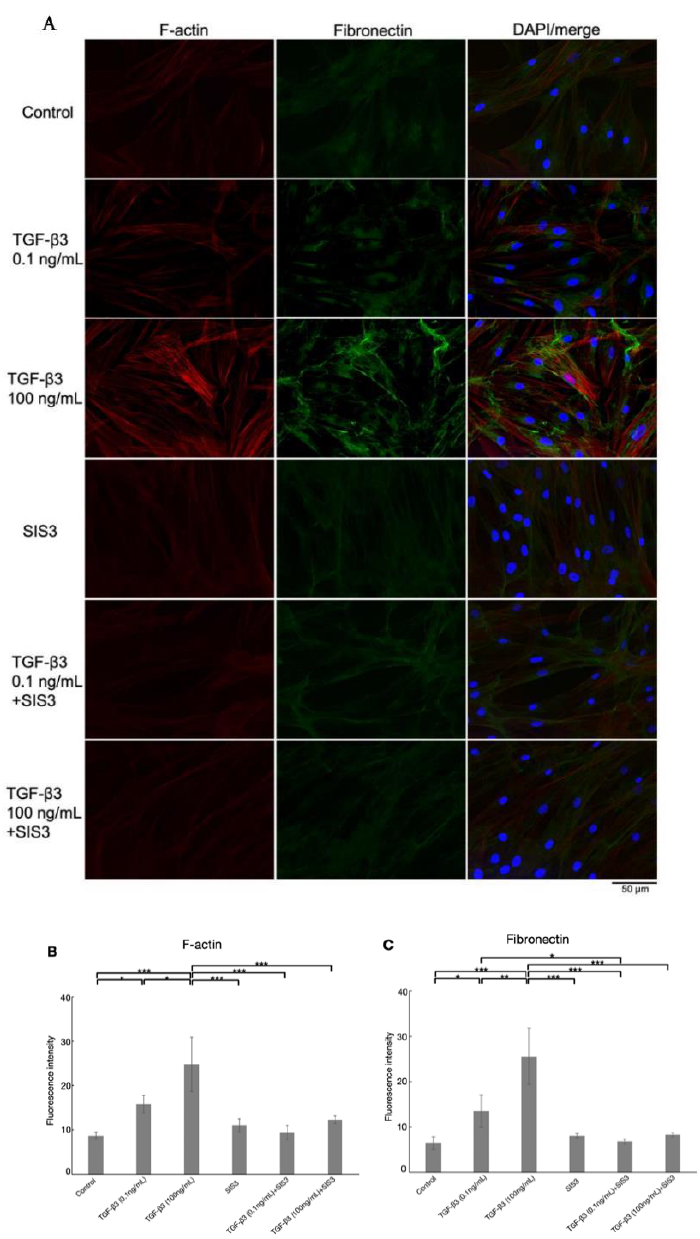
Figure 7. ( A ) Immunocytochemistry of F-actin and fibronectin in HTM cells after treatment with TGF- β3, with or without the Smad3 inhibitor, SIS3, and ( B , C ) the quantitative results based on immunocytochemistry. The left panels show cells stained for F-actin (red). The middle panels show cells stained for fibronectin (green). The right panels show merged images. The levels of F-actin were increased by 0.1 and 100 ng/mL TGF- β3 significantly, but the changes treated with 100 ng/mL TGF- β3 were suppressed by cotreatment with SIS3 significantly. The levels of fibronectin were significantly increased with 0.1 and 100 ng/mL TGF- β3, while the upregulated changes were reduced by cotreatment with SIS3 significantly. Data are presented as the mean ± standard deviation. * p < 0.05, ** p < 0.01, *** p < 0.001. Bar, 50 μm, n = 4.